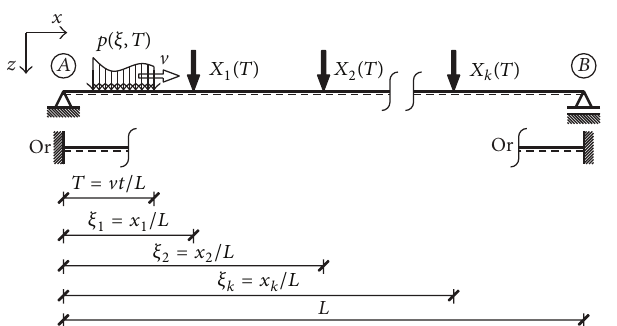
Figure 6: A single-span beam subjected to a given moving load and 𝑘 redundant